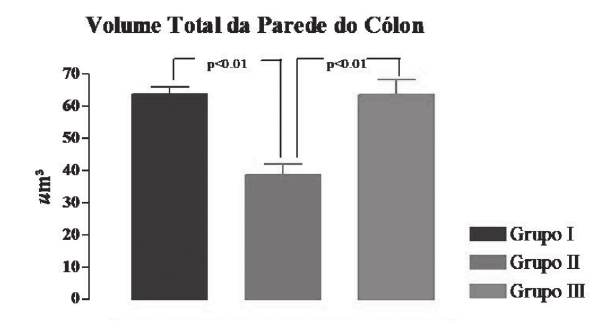
FIGURA 3 – Variações do volume total da parede do cólon entre os grupos controle